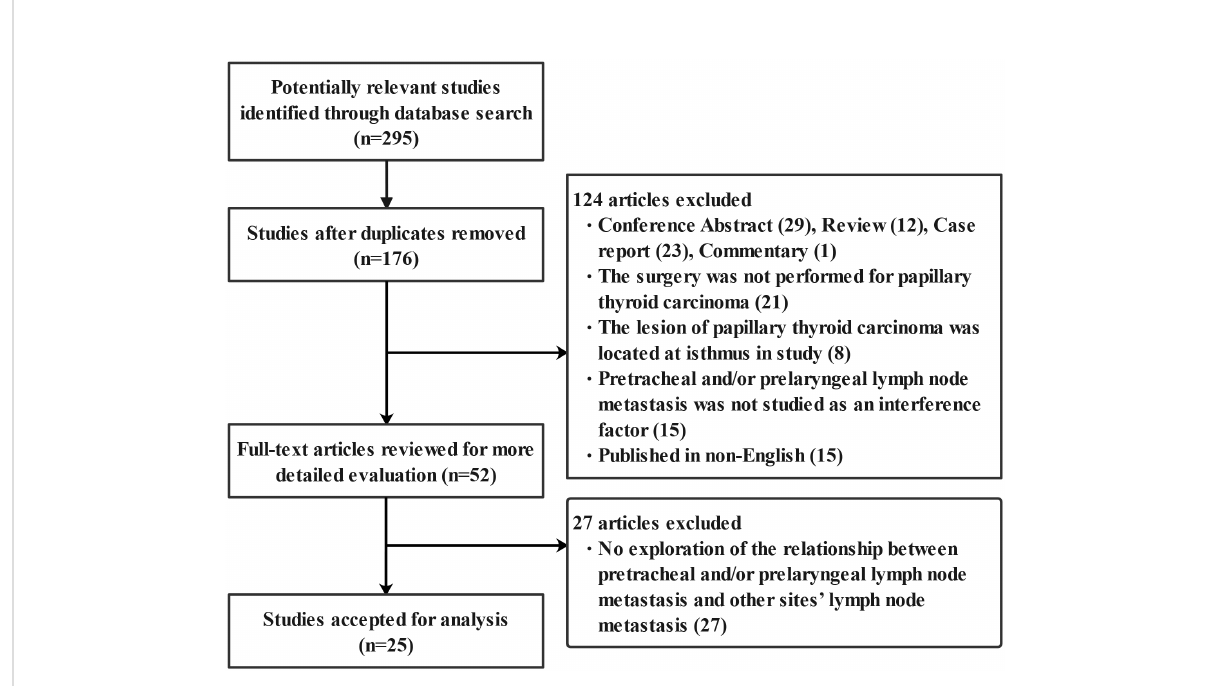
FIGURE 1 Flow chart of study